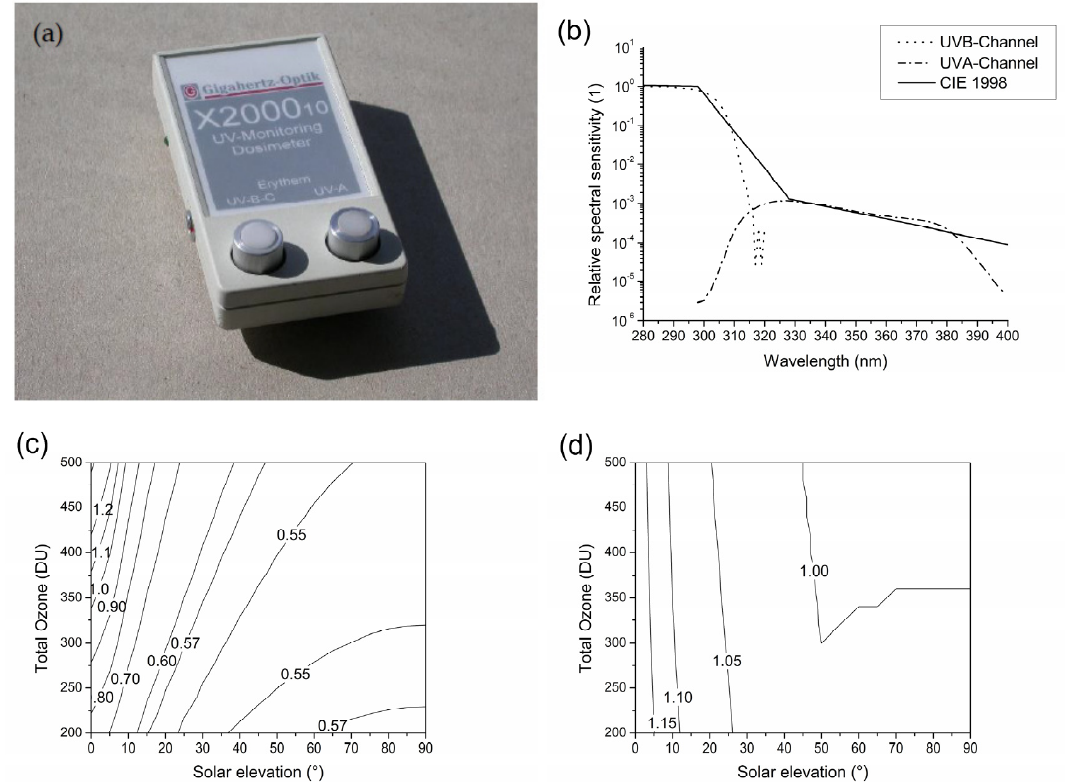
Figure 8. ( a ) 2-Channel personal irradiance meter. ( b ) spectral response of UV-B and UV-A channels compared to the erythema action spectrum [32]. ( c ) visualization of the calibration matrix (solar elevation and total ozone) for the UV-B channel and ( d ) for the UV-A channel to gain the erythemally effective UV irradiance (according